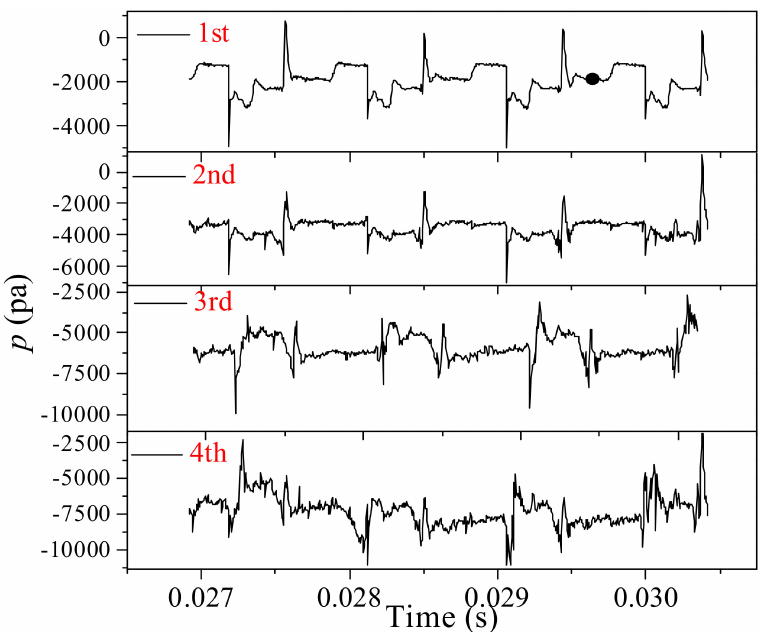
Figure 8. The e ff ect of a fractal structure on the time evolution of the pressure at the center of each bifurcation ( Ca 0 =